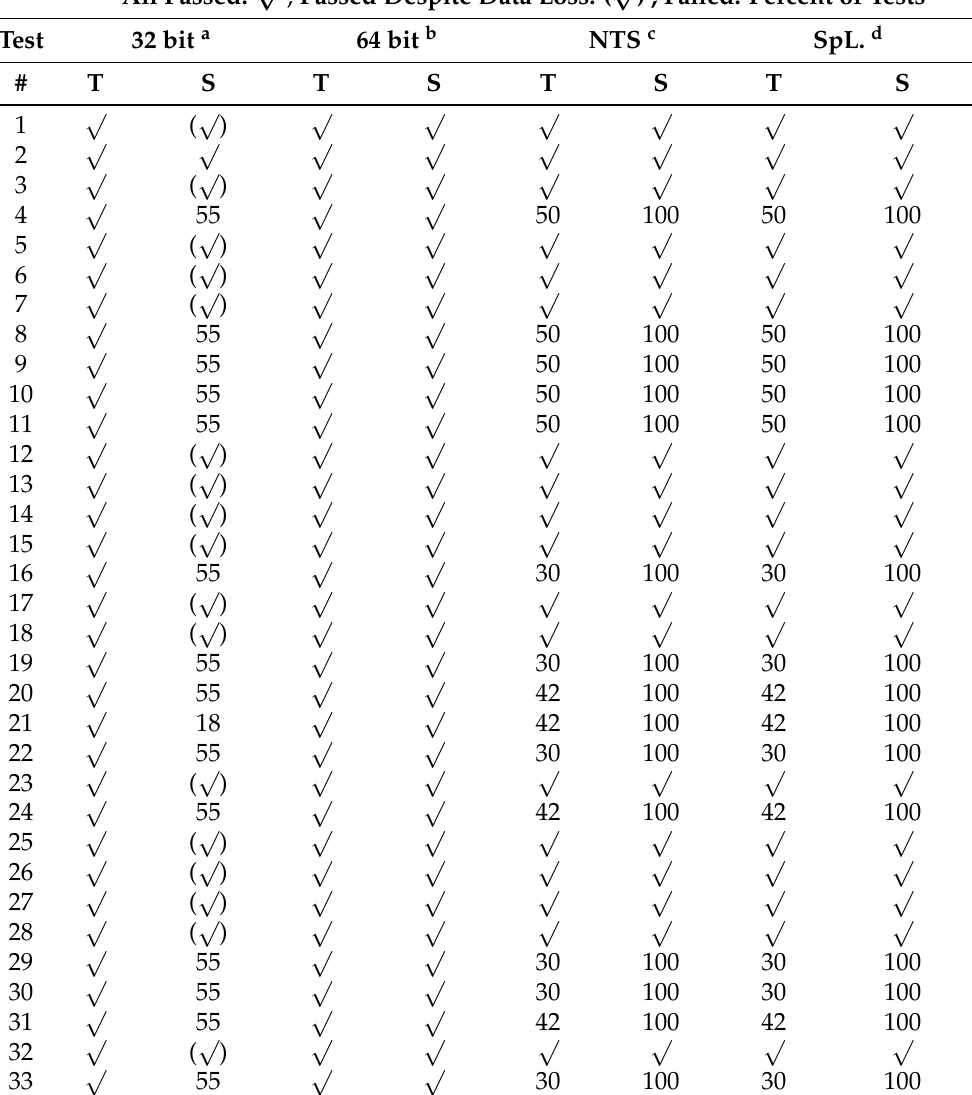
Table 8. Results after translation (T) and scaling (S) according to test